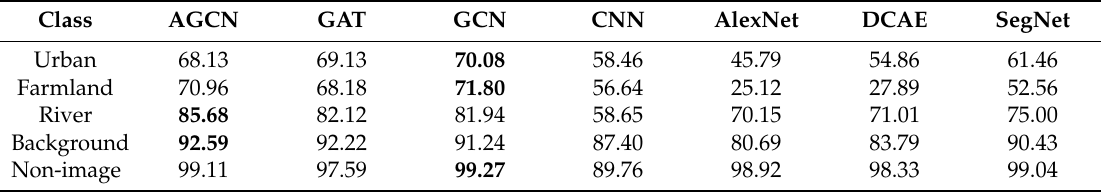
Table 4. Comparison of the pixel-wise F1-scores for individual classes with six state-of-the-art methods.